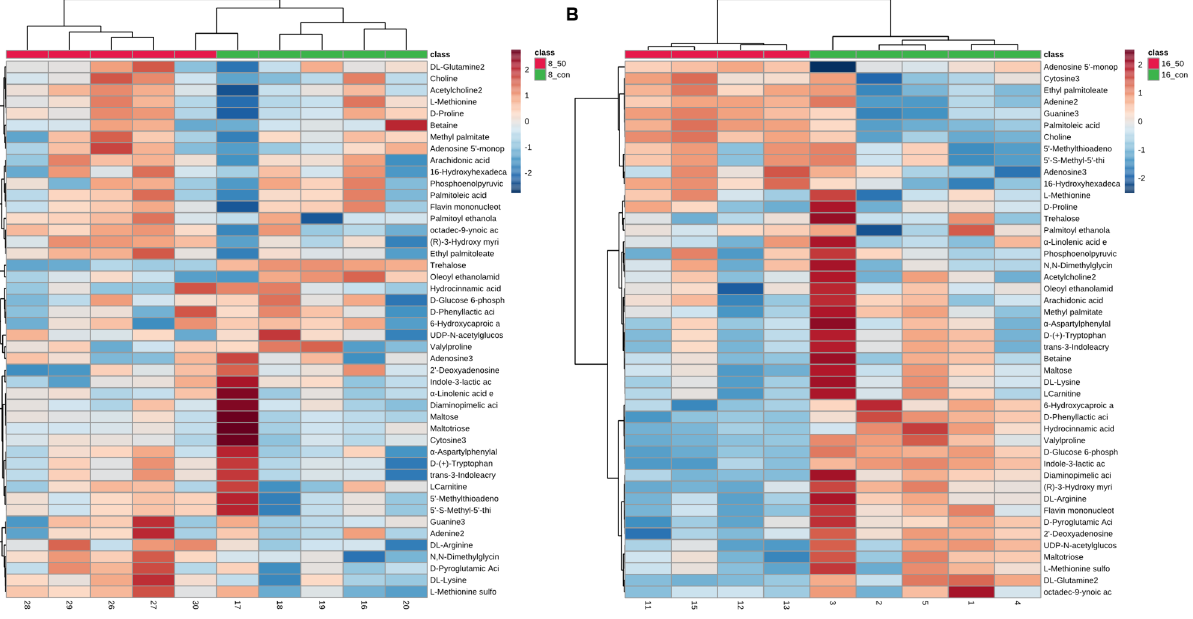
Figure 6. Enrichment diagram of the L. plantarum metabolic pathway after PAT exposure. ( A ) The 8 h group and ( B ) the 16 h group.